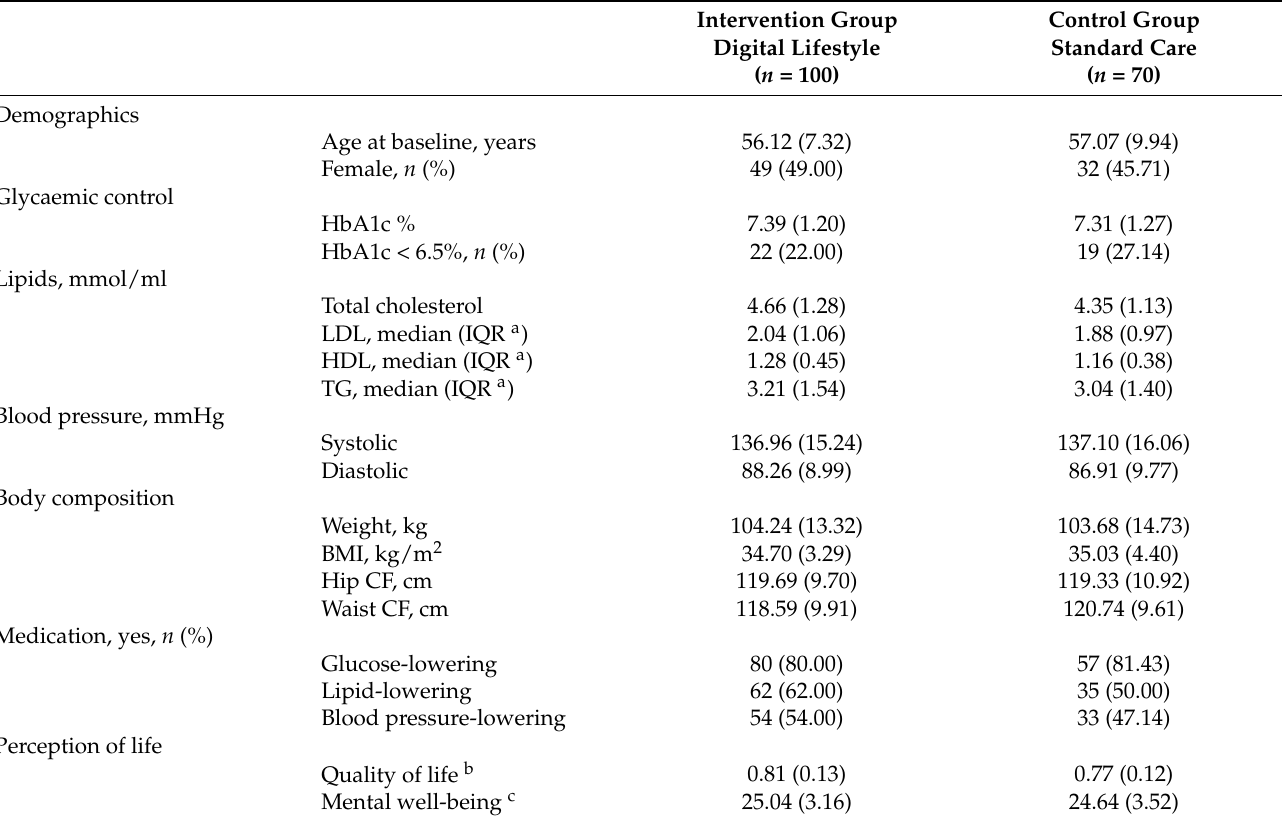
Table 3. Patient